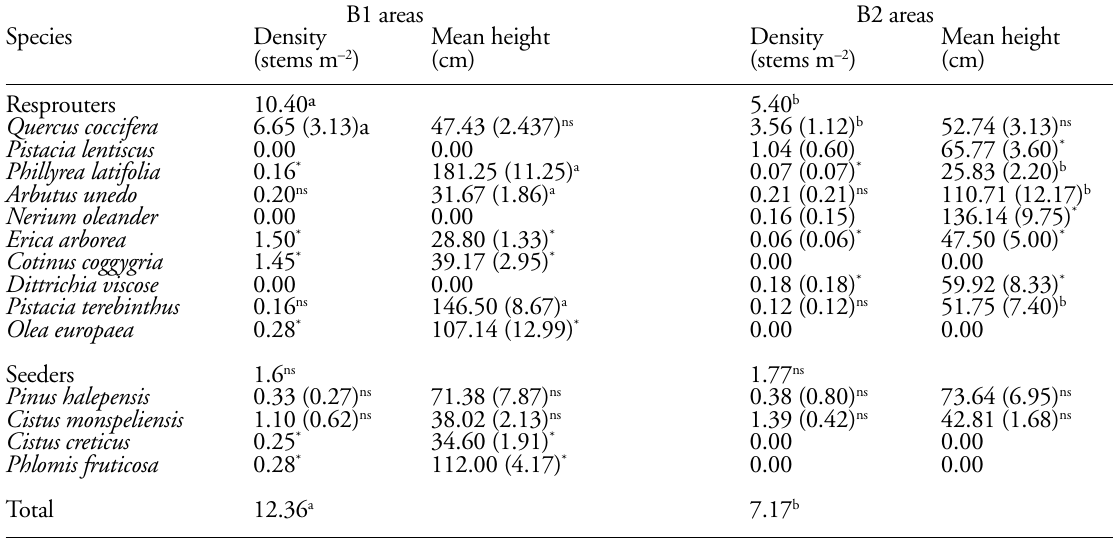
Table 2. Post-fire density and height growth of woody species, in B1 and B2, five years after the wildfire. Values are means and standard error of means (in parenthesis). Values of the same species for the same parameter followed by different letters are significantly different, ns = non-significant differences, * = insufficient data for the